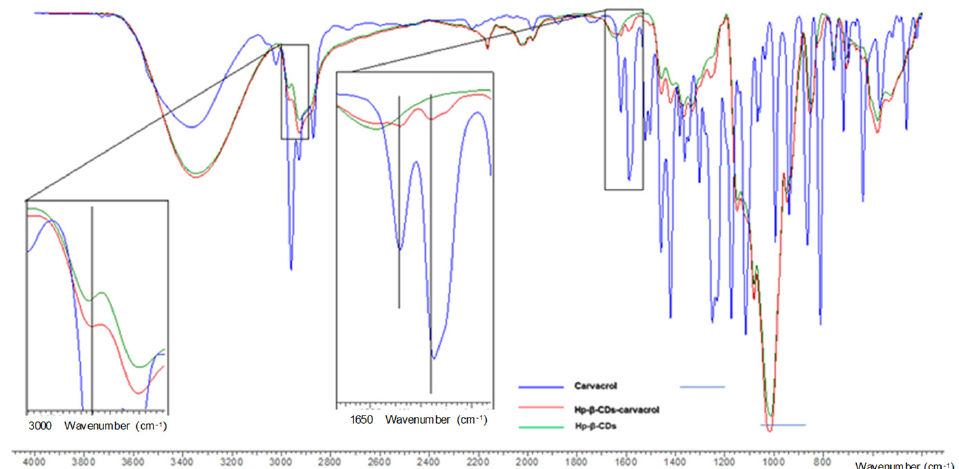
Figure 10. The FTIR spectrum of HP- β -CDs ( green line ), carvacrol-HP- β -CDs complexes by US ( red line ), and carvacrol ( blue line ). The vertical lines indicate the maximum of the HP- β -CDs curve. In the IR spectrum of carvacrol (Figure 10), we can see the stretching bands associated with the -OH in the 3361 cm − 1 region, the flexion bands out of the OH plane at 1457 cm − 1 , the stretching bands at the C=C aromatic compound at 1619 and 1587 cm − 1 , and the aromatic CH bond outside the 736 cm − 1 plane. In addition, there are symmetric and asymmetric stretching bands of methyl appearing at 2869 and 2958 cm − 1 ,